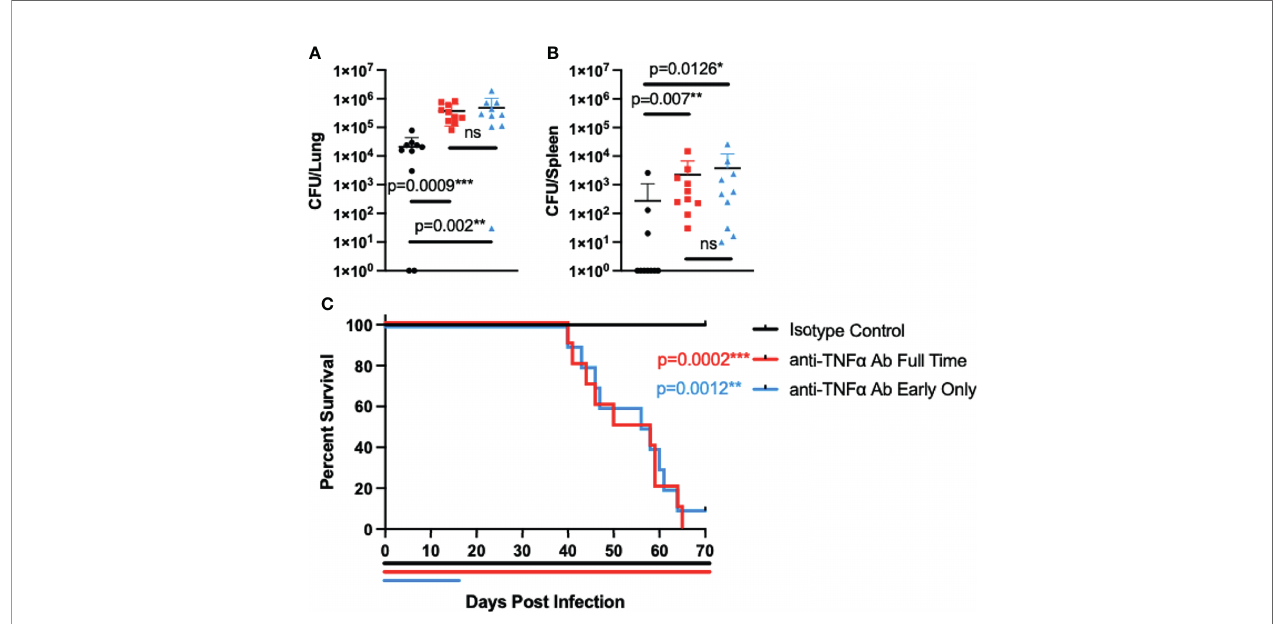
FIGURE 3 | Interrupting treatment of B6D2F1 with anti-TNF a antibody after infection still results in progressive Coccidioides disease. B6D2F1 mice were treated with 500 m g isotype control (black symbols) or anti-TNF a antibody (red symbols) starting on day -2 before infection; dosing was continued on an alternating q3/4d schedule. A third group of B6D2F1 mice was only treated for the fi rst 14 days of the infection (blue symbols). And 28 days after the infection, a subset of mice (n = 8/group) were sacri fi ced and lung (A) and spleen (B) fungal burdens were determined by serial dilution. The remaining mice (n = 10/group) were followed for disease progression (C) . Treatment timelines are indicated by colored lines below the survival graph. Data are represented as mean with standard deviation. Differences in fungal burden were tested for signi fi cance using a Kruskal – Wallis on log-transformed data. Survival differences were determined using Mantel – Cox. ns, not signi fi cant.